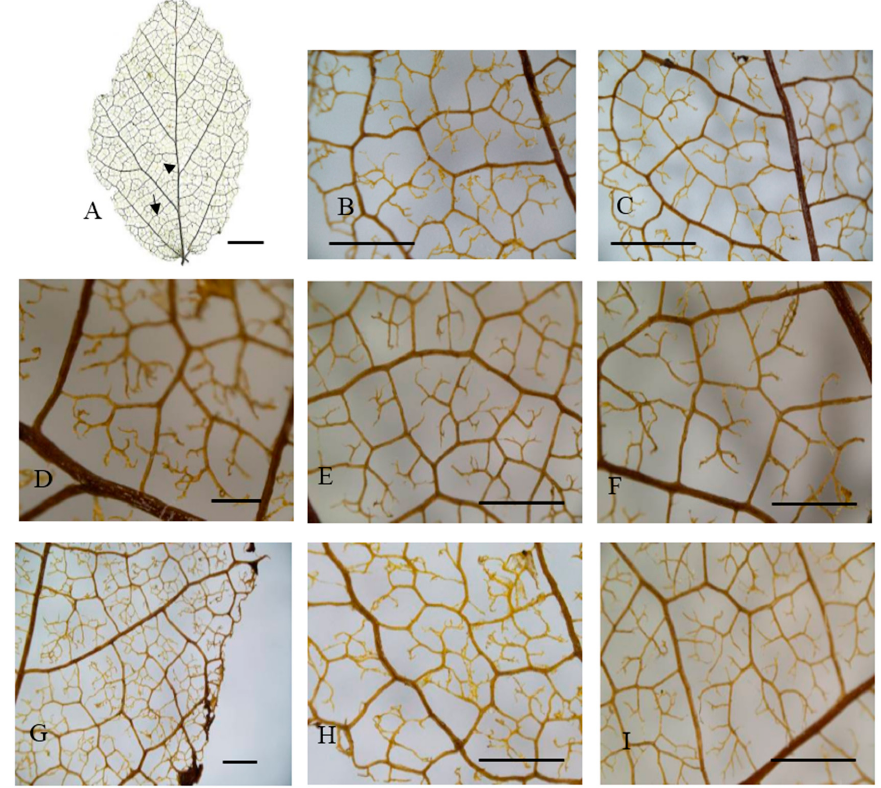
Figure 3. Leaf venation of hillside trees in eastern China. ( A ) General vein pattern; ( B , D – F , I ) Areolation; ( C , G , H ) Looped marginal ultimate venation. Arrowhead: basal veins. ( A ) Shucheng, Anhui; ( B , C ) Jinzhai, Anhui; ( D , G ) Xinyang, Henan; ( E , F , I ) Huoshan, Anhui; ( H ) Yuexi2, Anhui. Arrow: agroaphic veins. Scale bar: ( A ): 1 cm; ( D ): 500 µm; ( B , C , E – I ): 1000 µm.